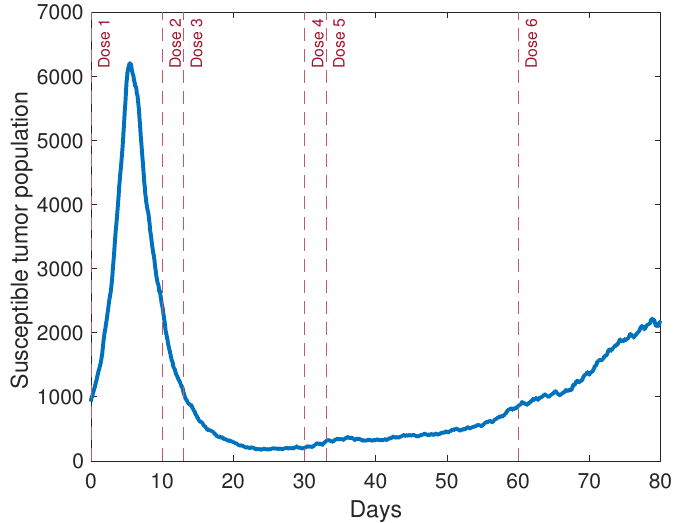
Figure 6. A simulation of the ABM with the chosen viral dosing schedule obtained from sequen- tially testing each dose. In this simulation, a AT = 0.07, and all other parameters are set at their baseline